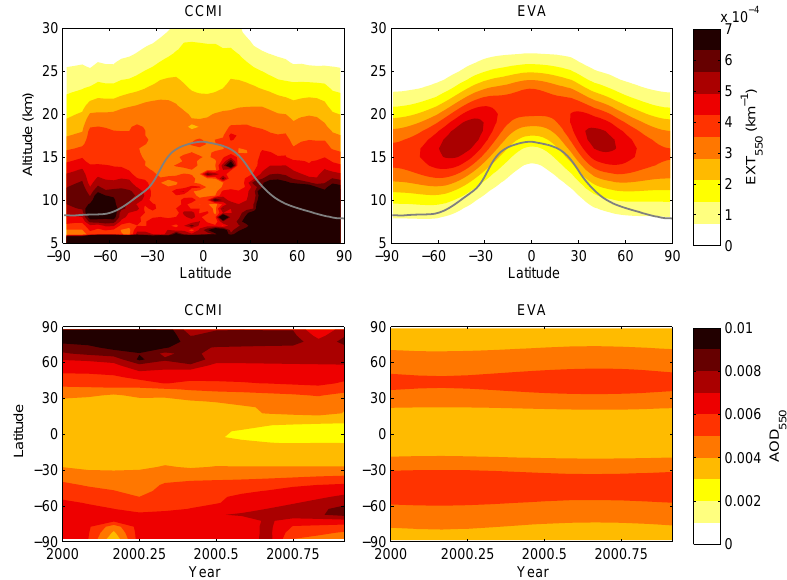
Figure 11. Top: aerosol extinction at 550nm averaged over the year 2000 from (left) the CCMI observation-based reconstruction and (right) EVA. Bottom: AOD at 550nm through the year 2000 from (left) CCMI and (right) EVA.